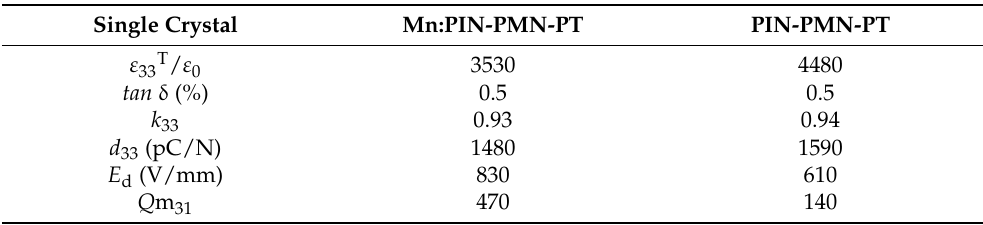
Table 2. Typical properties for Mn-doped and non-doped PIN-PMN-PT single